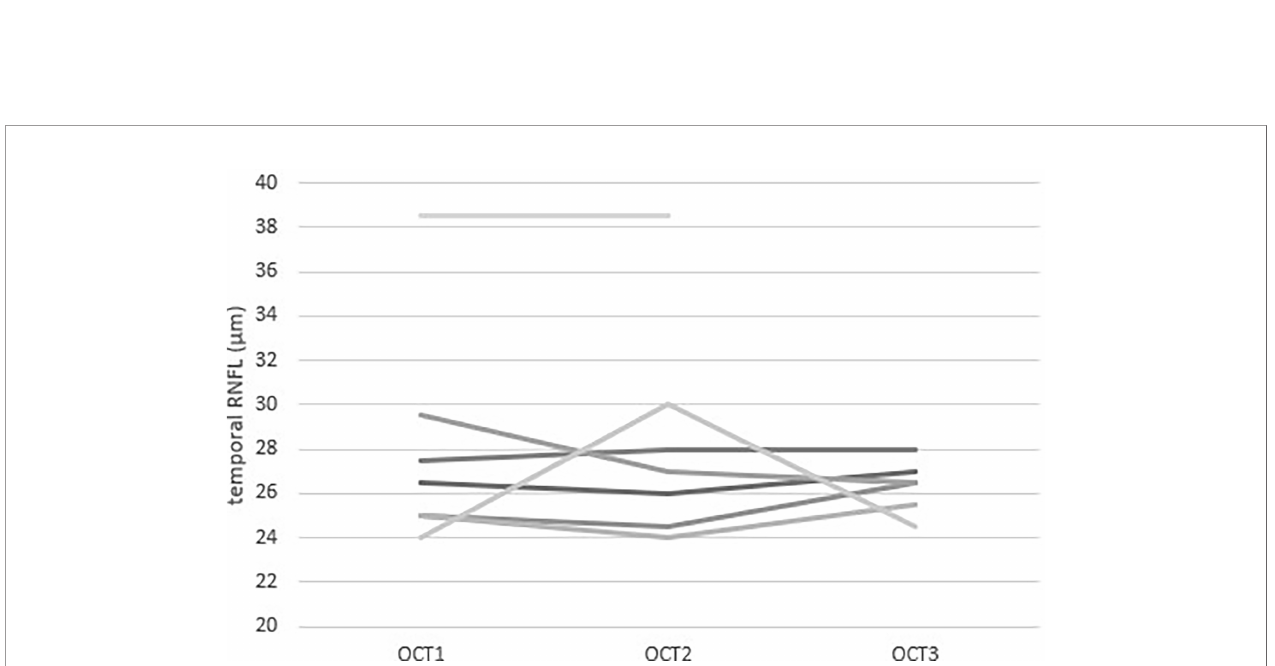
FIGURE 2 | Repeated measurements of Temporal RNFL thickness measured by OCT in 7 paediatric patients with Triple A syndrome. Each value is the mean of the two eyes of one patient. Each line represents a patient. Three patients had three measurements during their follow-up. The mean time between OCT1 and OCT2 was 7.9 months and the mean time between OCT2 and OCT3 was 9.3